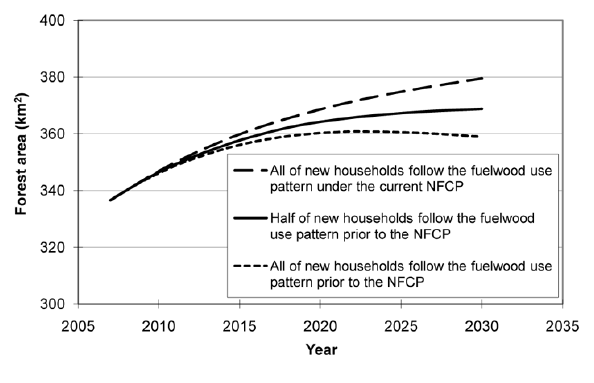
Fig. 5 . Predicted forest area under different fuelwood use patterns followed by new households, i.e., households formed after